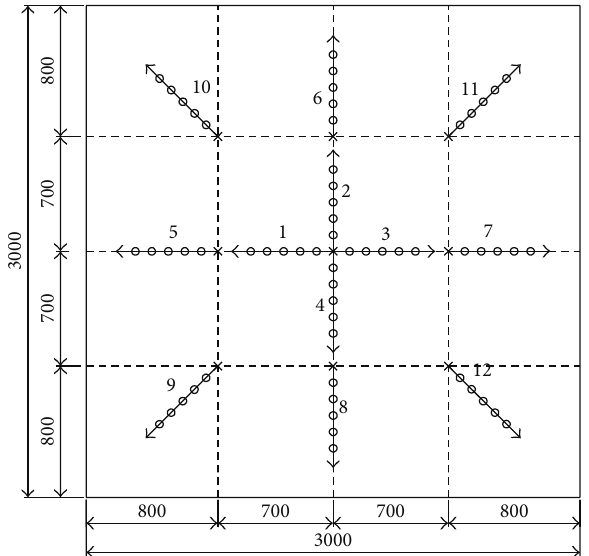
Figure 14: A plan view of the 12 test paths for the R-wave measure- ment. The ∘ marks indicate the sensor positions in each path, and the arrows show the direction of each test.